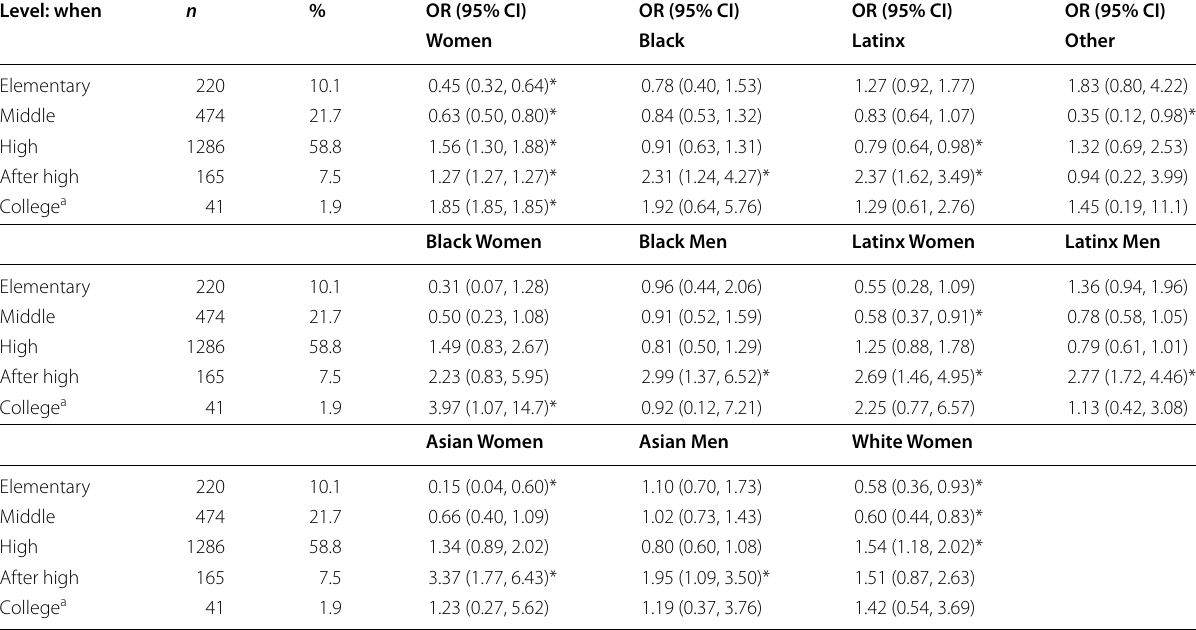
Table 3 When students first consider engineering as a college major: bivariate analysis by gender, race/ethnicity, and gender‑race/ ethnicity intersection